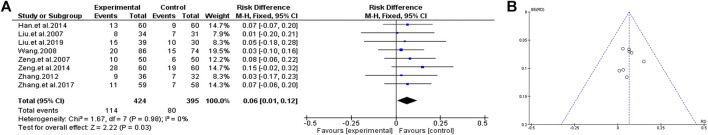
Clinical effects of TCM assisted antipsychotics vs antipsychotics therapy alone. (A) Forest plot. (B) Funnel plot.